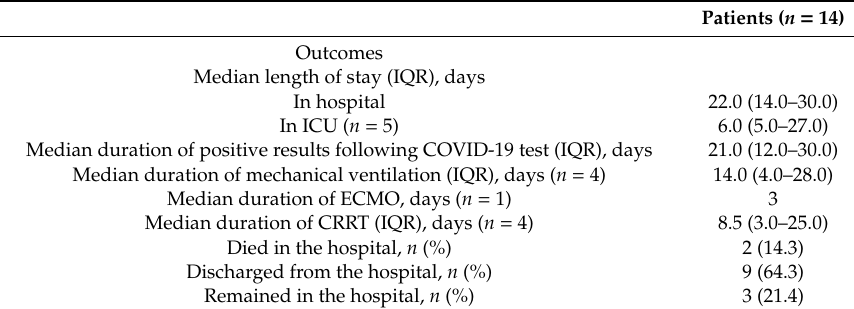
Table 4. Clinical outcomes.